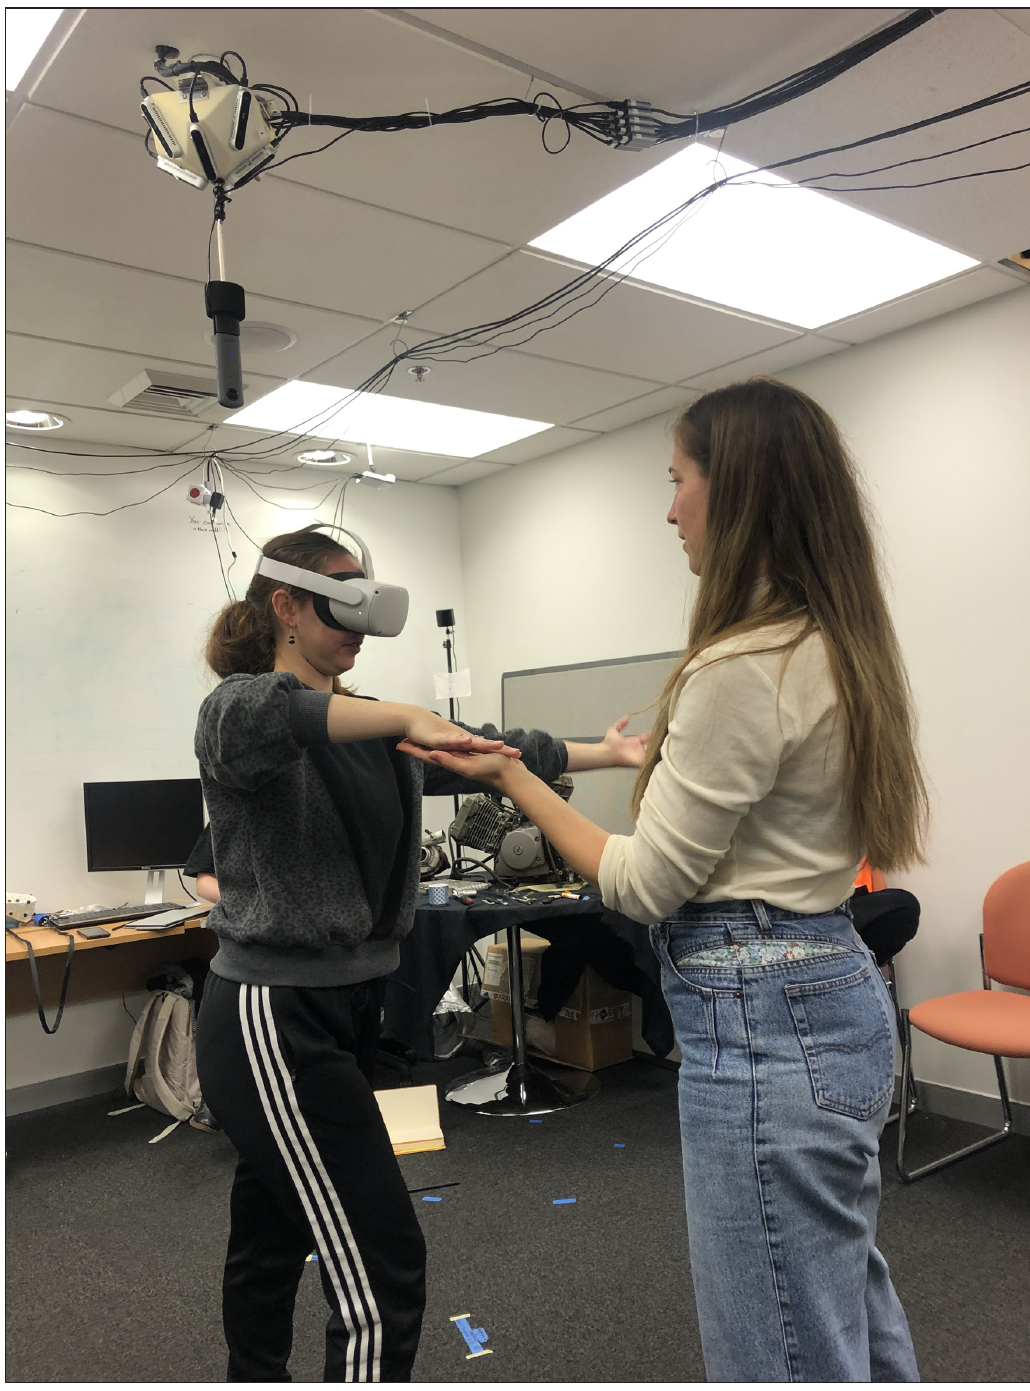
Figure 4: Touch as a grounding point in